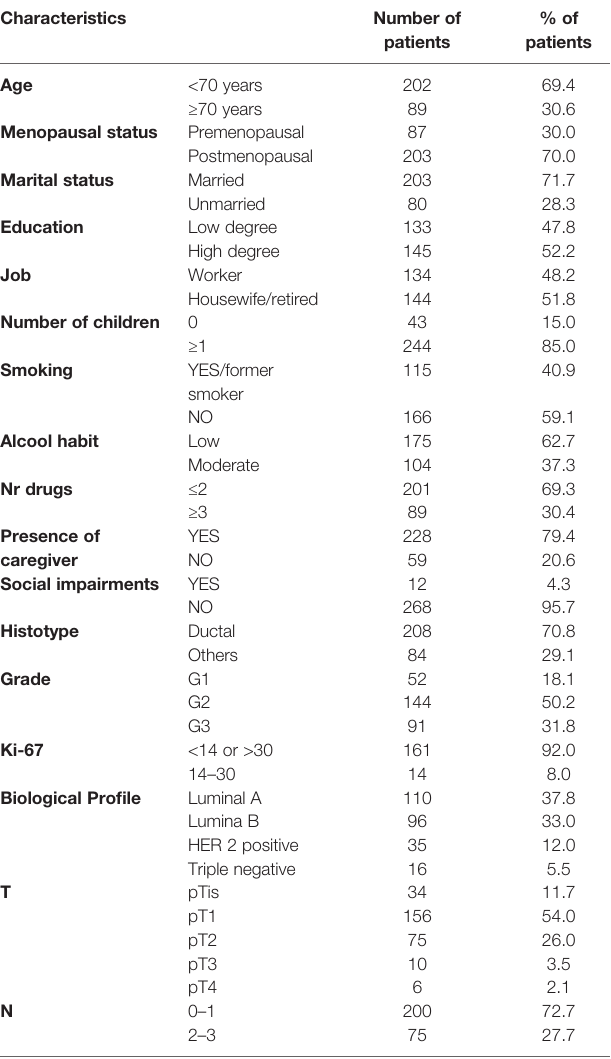
TABLE 1 | Baseline patients ’ clinicopathological characteristics.